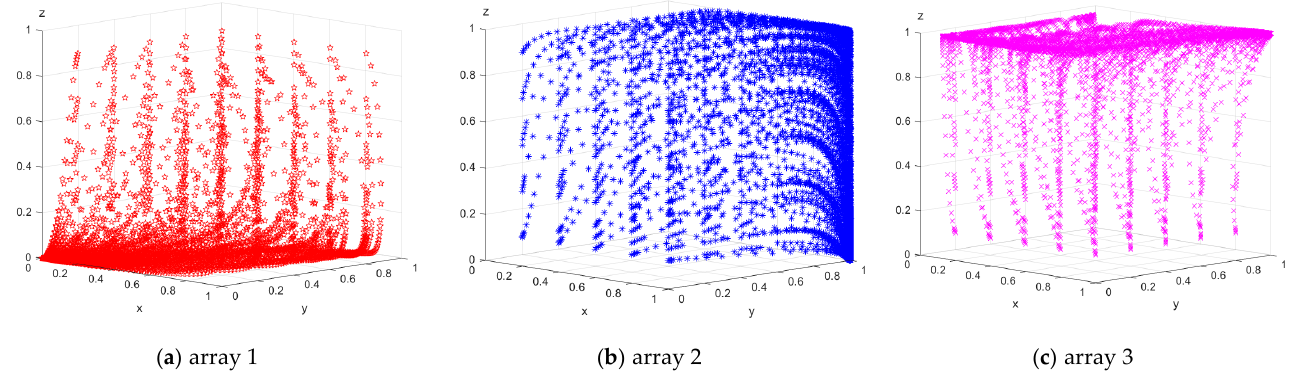
Figure 12. The result of 100 evolutions of arrays 1, 2, and 3. Array 2: As shown in Figure 12b, R S = 13, R D = 8, C E = 7, C PS = 14, C PD = 19, C Z = 5, U S = 7, U D = 3, M S = 40, M D = 30, T = 6, L = 2, F = 17, W = 38, α = 0.65, β = 0.35, ω = 0.3, and θ = 0.6. Array 3: As shown in Figure 12c, R S = 13, R D = 8, C E = 12, C PS = 26, C PD = 19, C Z = 5, U S = 7, U D = 3, M S = 40, M D = 30, T = 6, L = 2, F = 25, W = 38, α = 0.65, β = 0.35, ω = 0.3, and θ =